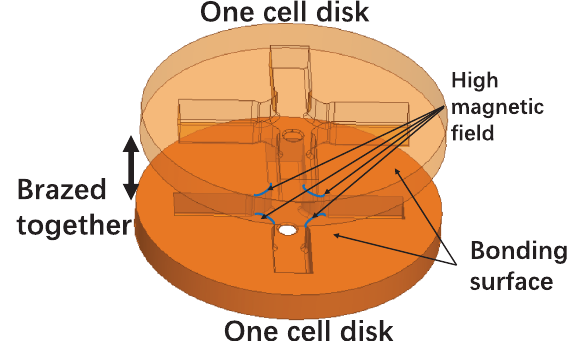
FIG. 1. Conventional way of manufacturing an accelerating structure.